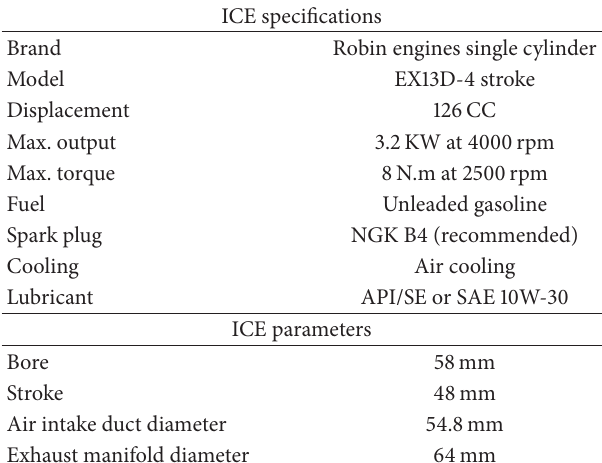
Table 1: Specifications and parameters of the internal combustion engine.